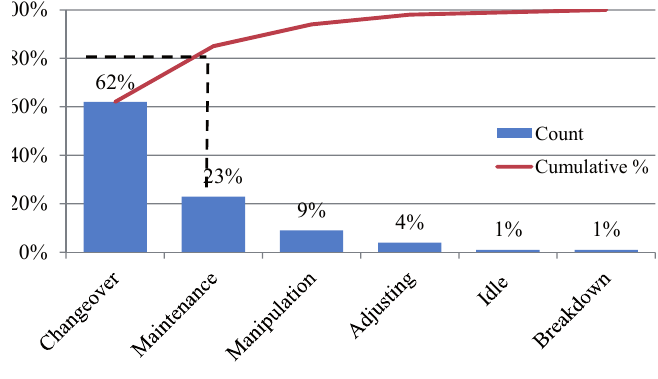
Fig. 2 – Pareto analysis – downtime (Filla,